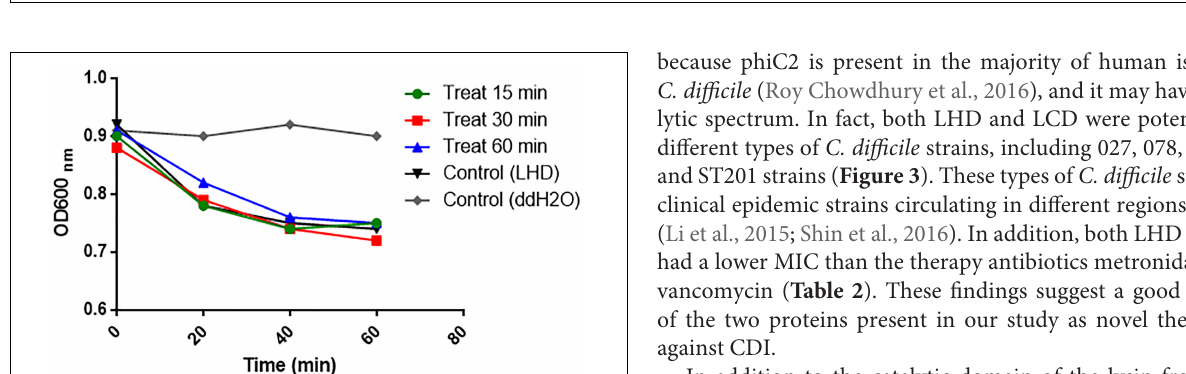
FIGURE 8 | Clostridioides difficile spores and toxin levels in fecal samples of mice infected with C. difficile R20191 spores with/without LHD treatment. C. difficile spore numbers (A) , Tcd A level (B), and Tcd B level (C) in two groups of mice infected with R20291 spores with/without LHD treatment, respectively. Experiments were repeated 3 times, and representative data were shown. Data are present as “Mean ± SD”. ∗ p < 0.05.